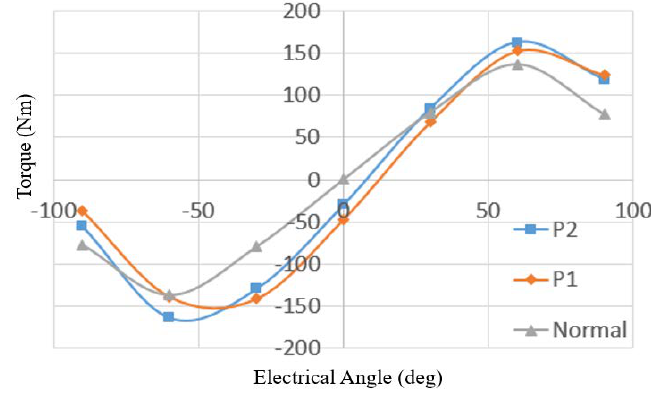
Figure 9. Comparison of the torque-angle of the two designs.